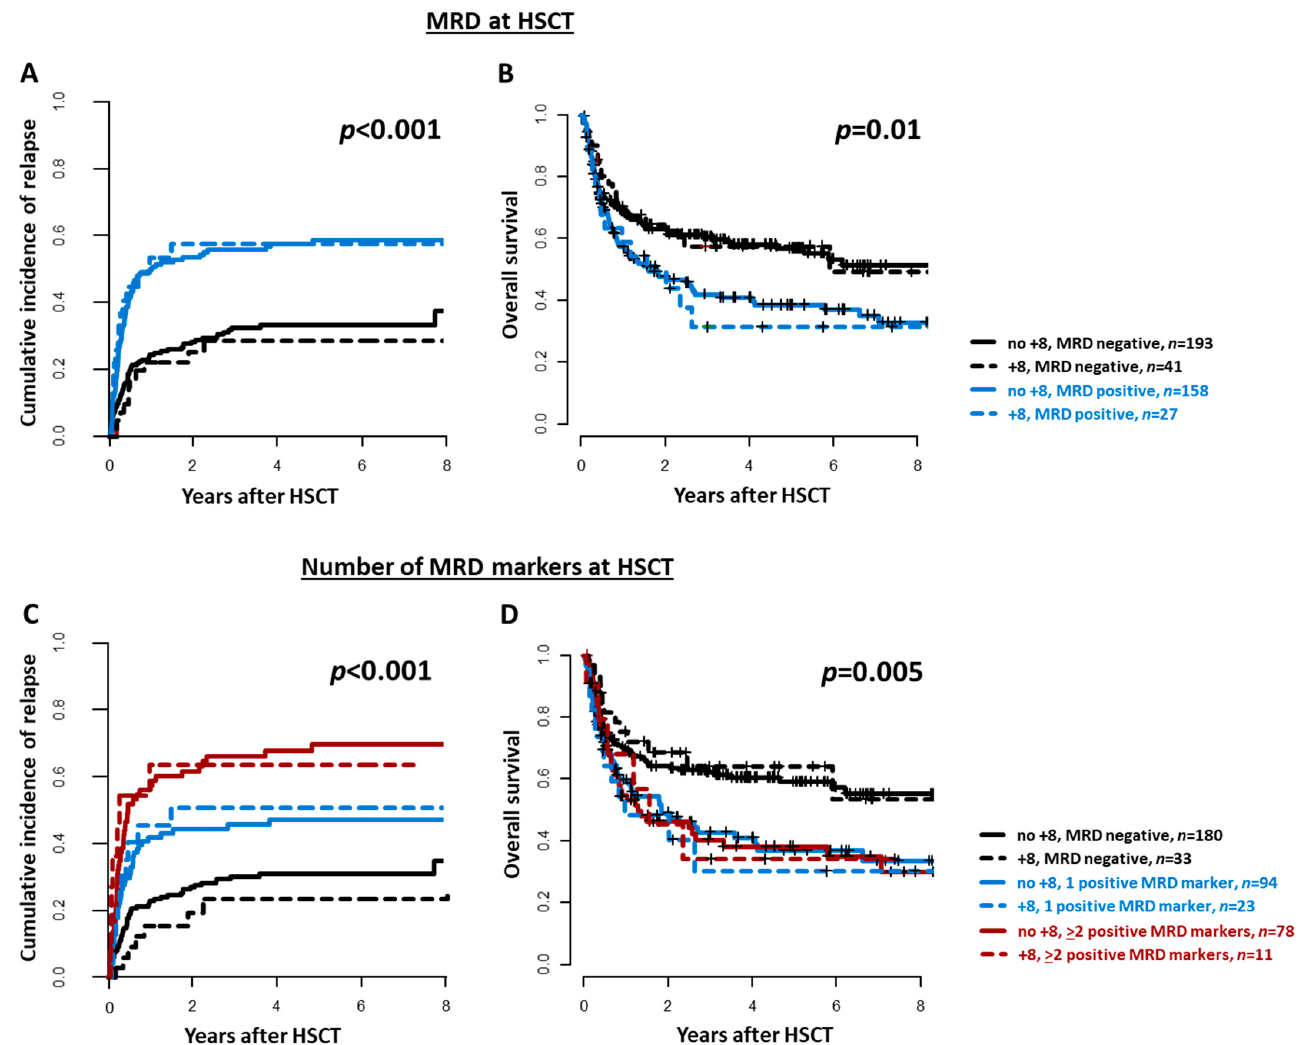
Figure 3. Outcomes according to the MRD status at allogeneic hematopoietic stem cell transplantation (HSCT) in AML patients with or without a trisomy 8 ( n = 419). ( A ) Cumulative incidence of relapse ( p for interaction = 0.64), and ( B ) Overall survival ( p for interaction = 0.79) (MRD-positive vs. MRD-negative). ( C ) Cumulative incidence of relapse ( p for interaction = 0.52), and ( D ) Overall survival ( p for interaction = 0.63) according to the number of positive MRD markers (0 vs. 1 vs. 2 or